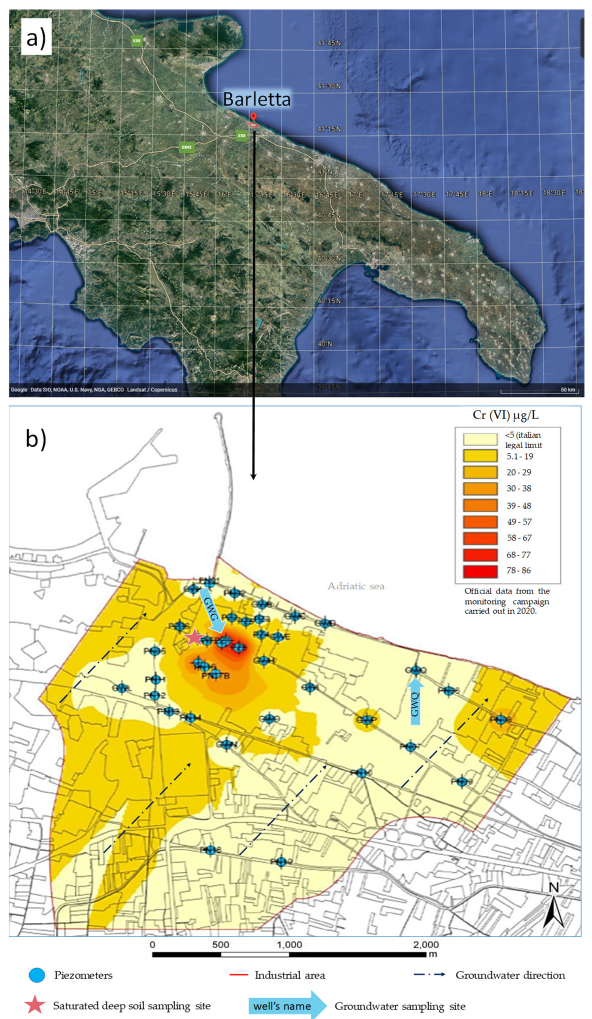
Figure 1. ( a ) Location of the Barletta Municipality, Apulia, Southern Italy (credit Google Earth, image Landsat/Copernicus, data SIO NOAA, U.S. Navy, NGA, GEBCO). ( b ) Sampling sites and Cr(VI) distribution in the study area according to the monitoring campaign carried out in 2020 (modified from [30]).